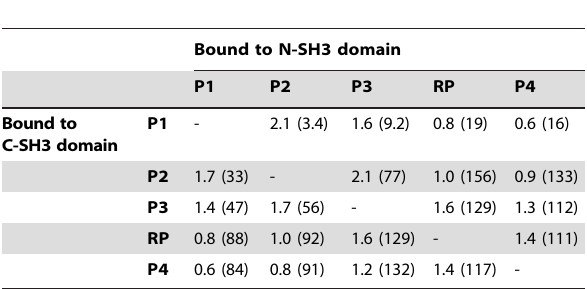
Table 3. Intramolecular binding of two motifs in one Sos1 molecule to the two SH3 domains of